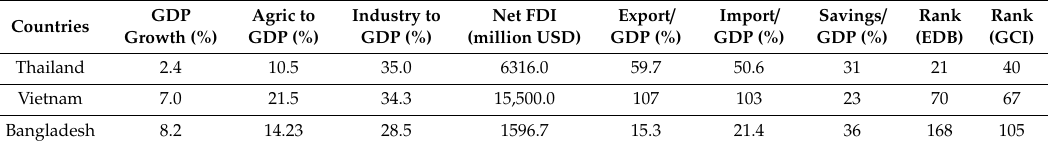
Table 1. Comparison of GDP growth and contribution of different sectors [13].